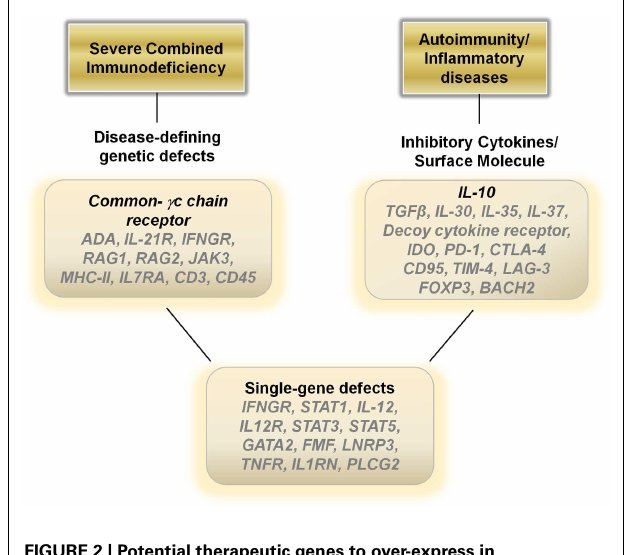
FIGURE 2 | Potential therapeutic genes to over-express in hematopoietic stem cells, monocytes, dendritic cells orT cells for autoimmune, inflammatory, and single-gene disorders